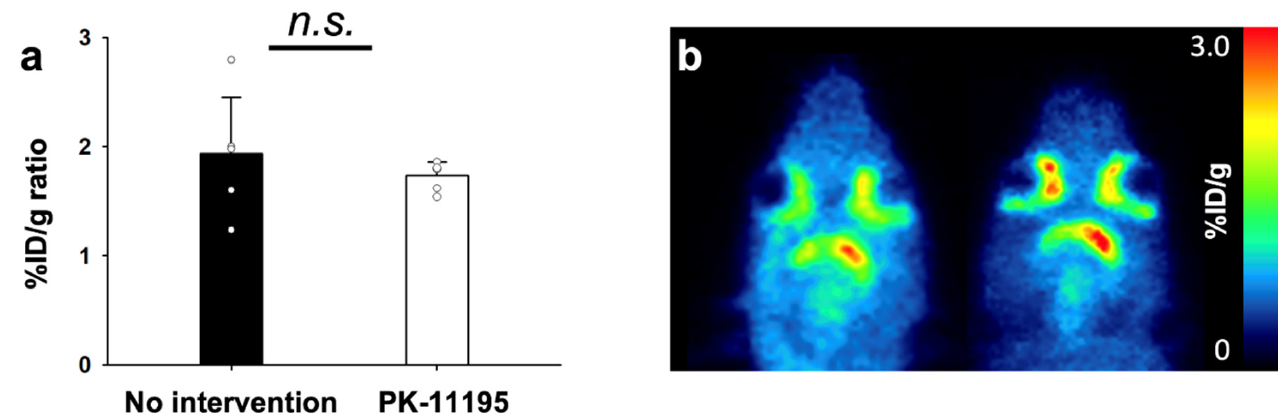
Figure 6. %ID/g ratios of 3-[ 18 F]F-CP118,954 ( 1 ) with and without PK-11195 treatment on day 2 after MCAO surgery ( a ). Representative AChE PET images of respective conditions ( b ). The statistical significance of differences were determined using the Mann-Whitney U test; n.s. : not significant.